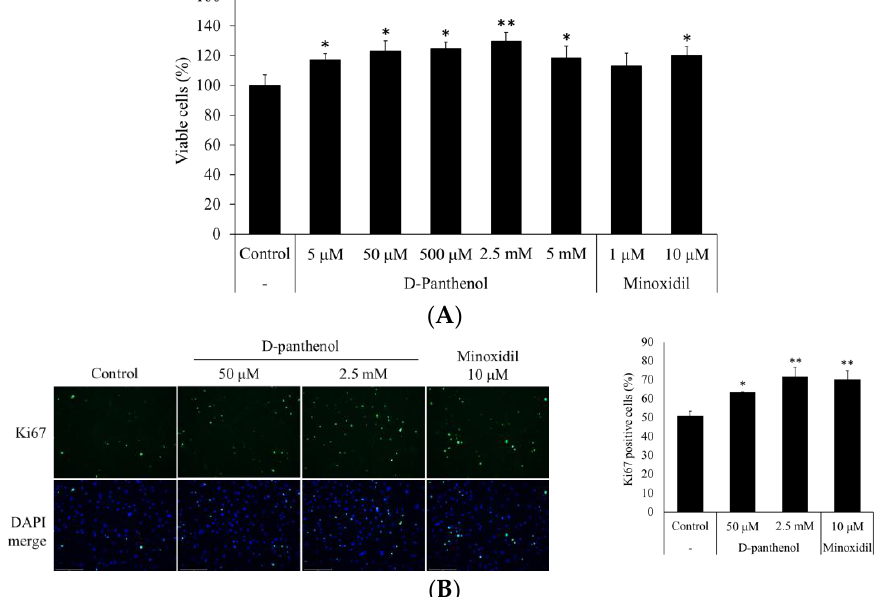
Figure 1. D-panthenol stimulated the growth of cultured human dermal papilla cells (hDPCs). ( A ) The growth of hDPCs was assessed by CCK-8 assay after 24 h treatment of D-panthenol. ( B ) Ki67, a cell proliferation marker was immunostained after 24 h treatment of D-panthenol and the propor- tions of Ki67 positive cells were calculated ( × 200 magnification). Ki67 positive cells were marked by green fluorescence and total cells were marked by DAPI. * p < 0.05, ** p < 0.01 versus control group. Data are expressed as mean ±